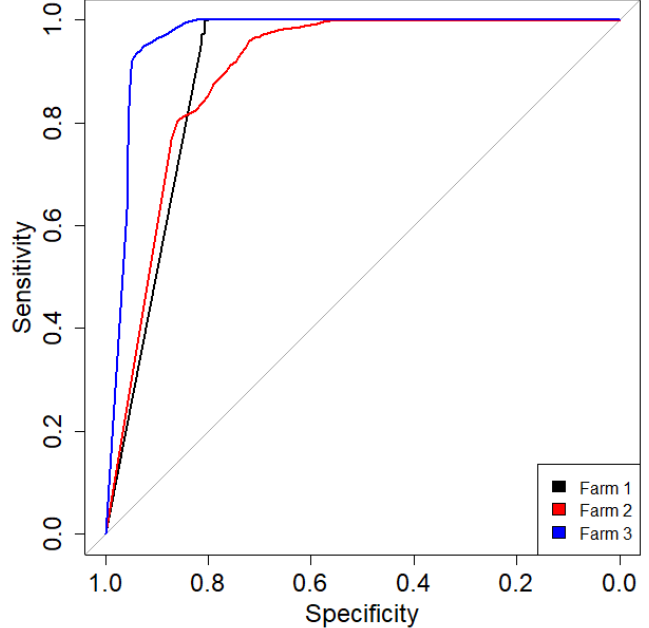
Figure 4. Receiver operating characteristic (ROC) curves for the test data of the three farms. Table 3. K-nearest neighbors parameter (k) computed and optimized on the training set and the area under the curve (AUC) computed on the test set.